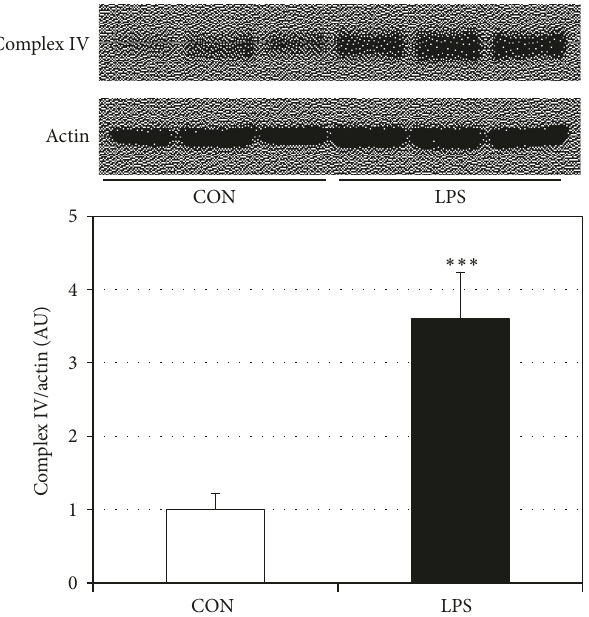
Figure 1: LPS increases complex IV protein expression in HGF-1 cells. Human gingival fibroblasts were treated with LPS (5 𝜇 g/mL) for 48 h, after which complex IV protein levels were determined ( 𝑛 = 4 ). ∗∗∗ 𝑃 < 0.001